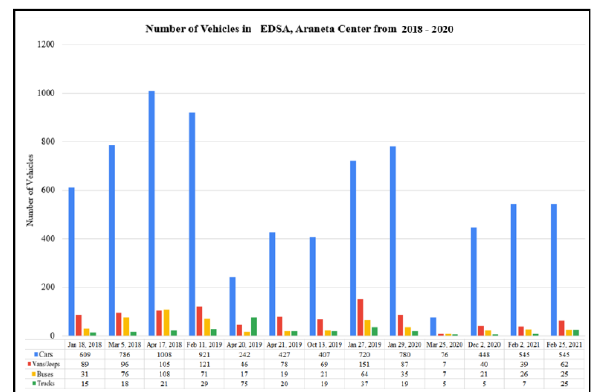
Figure 8. Number of Vehicles per Classification in E. Rodriguez Avenue, Eastwood City from 2018-2021